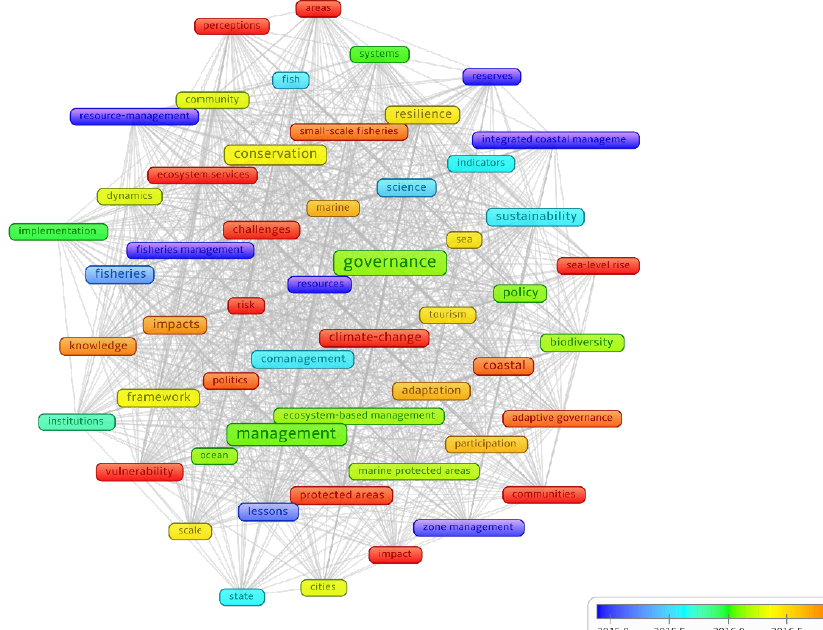
Figure 5. Keywords plus temporal co-occurrence graph.